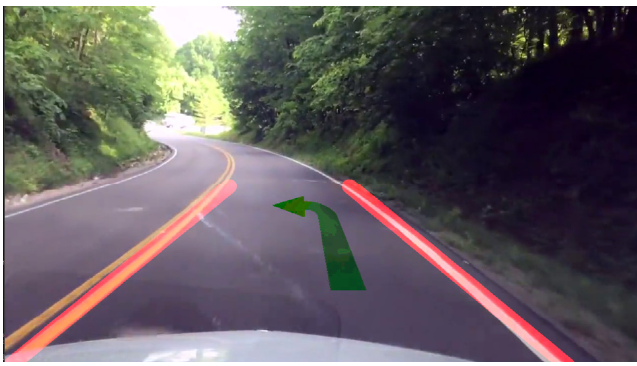
Figure 13. Turn sign displayed based on right lane slope.